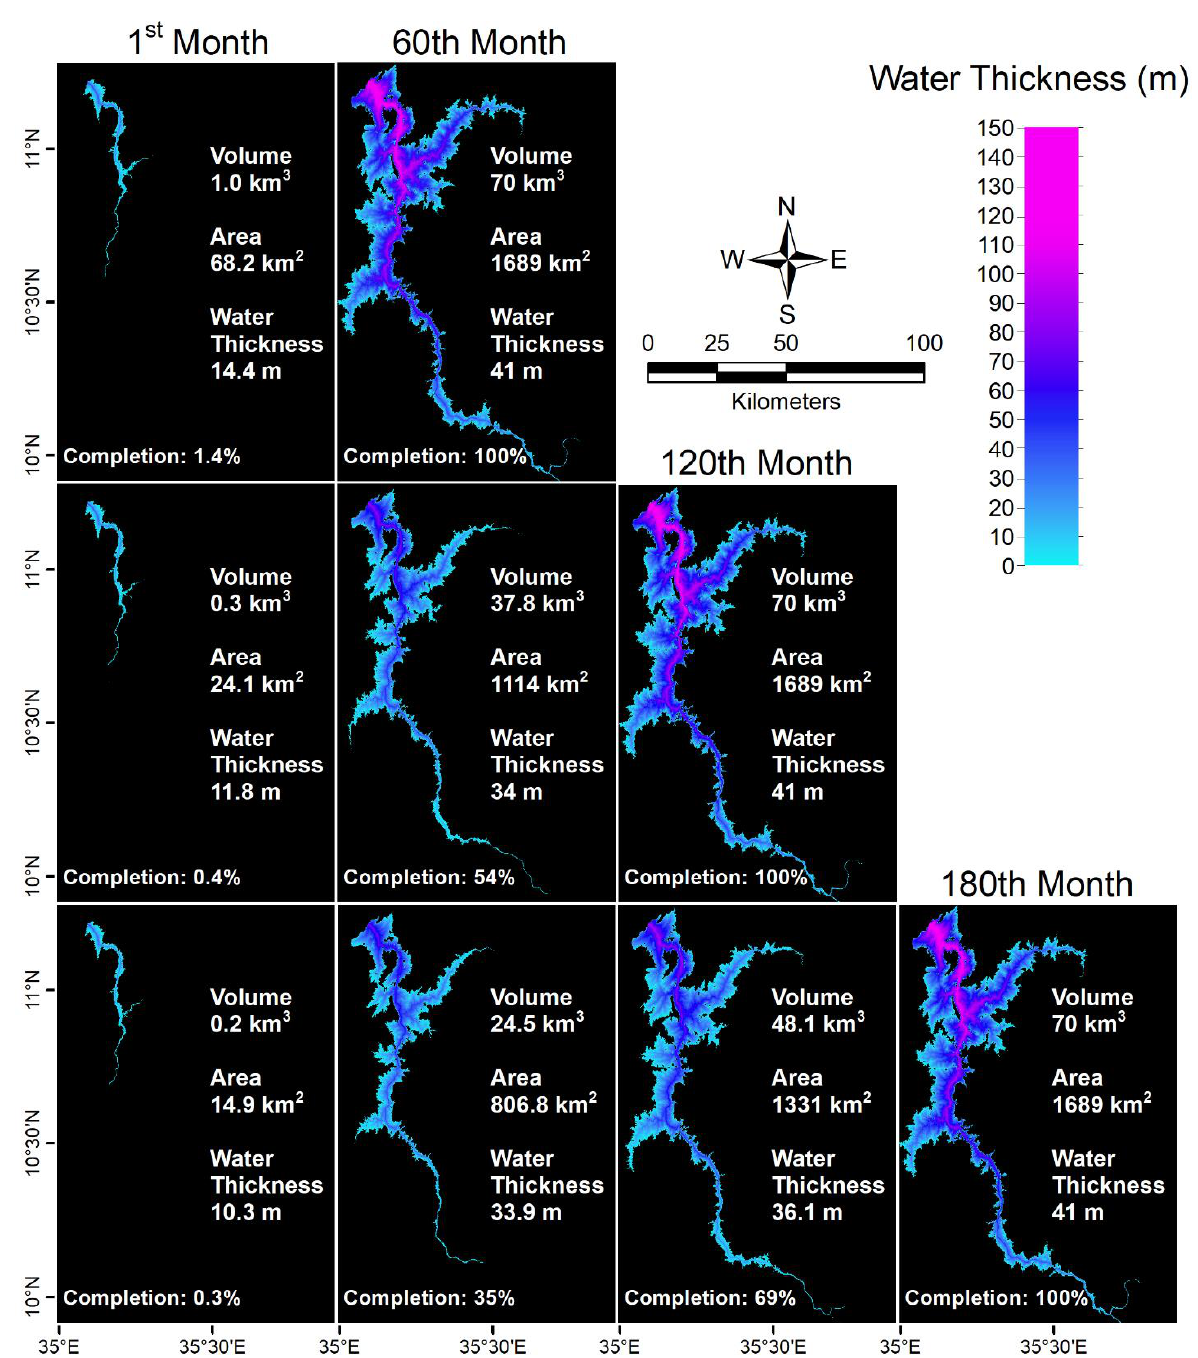
Figure 4. Spatiotemporal variability of the GERD reservoir volume, area, water thickness, and completion percentage for months 1 and 60 in the 5-year filling strategy (top row); months 1, 60, and 120 in the 10-year filling strategy (middle row); and months 1, 60, 120, and 180 in the 15-year filling strategy (bottom row).